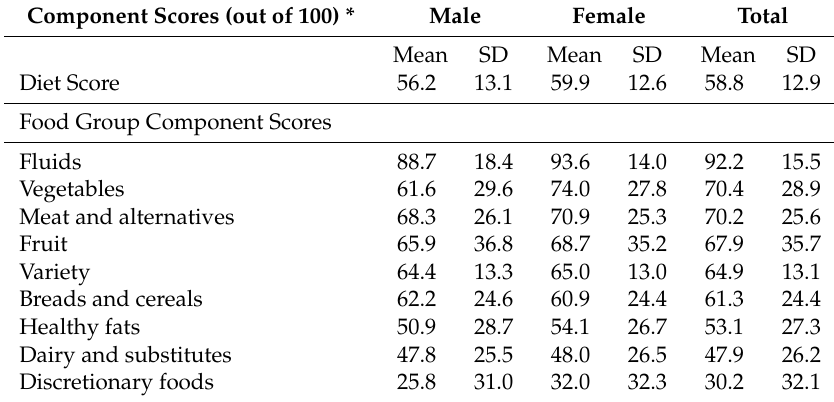
Table 2. CSIRO Healthy Diet Score and Food Group Components Scores by Gender and for the Total Sample ( n =